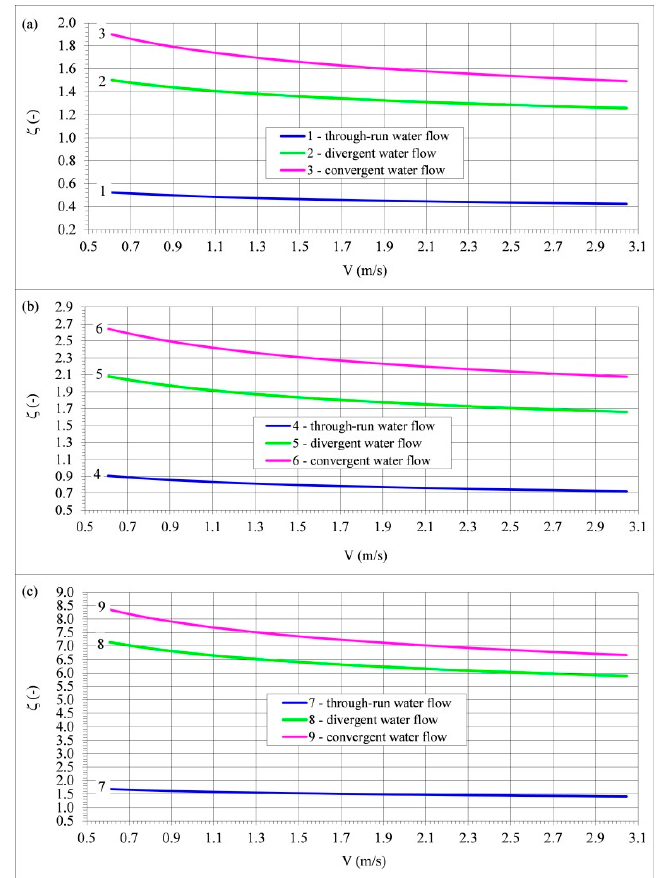
Figure 8. Nomogram for determining values of the local resistance coefficient ζ in welded polypropylene T-junctions with an internal diameter of 13.2 mm, depending on water flow velocity V: ( a ) properly warmed up and properly pressed T-junction, ( b ) poorly warmed up and poorly pressed T-junction, ( c ) excessively warmed up and excessively pressed T-junction.